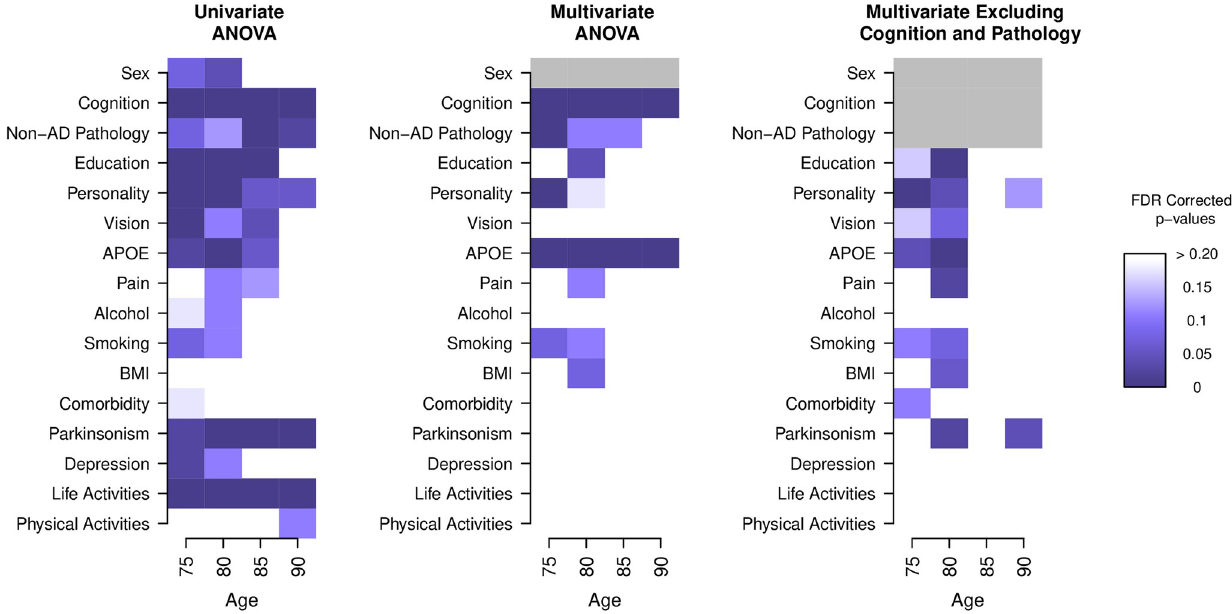
Fig 2. The cross-sectional nested ANOVA models for ages 75, 80, 85, and 90, with sample sizes of n = 198, 353, 413, and 284 respectively. The FDR corrected p-values are shown up to values of 0.20. We see that different measures are associated with an individual’s AD-CR Score at different time points in their lifetime and that there are more associations found in the younger age groups (75 to 80). Sex in the multivariate ANOVA model is shown in gray as all models are adjusted for sex and we do not test for an association of sex and AD-CR Score in these models. Cognition and non-AD pathology are also shown in gray as these are excluded from the multivariate ANOVA that excludes cognition and pathology.